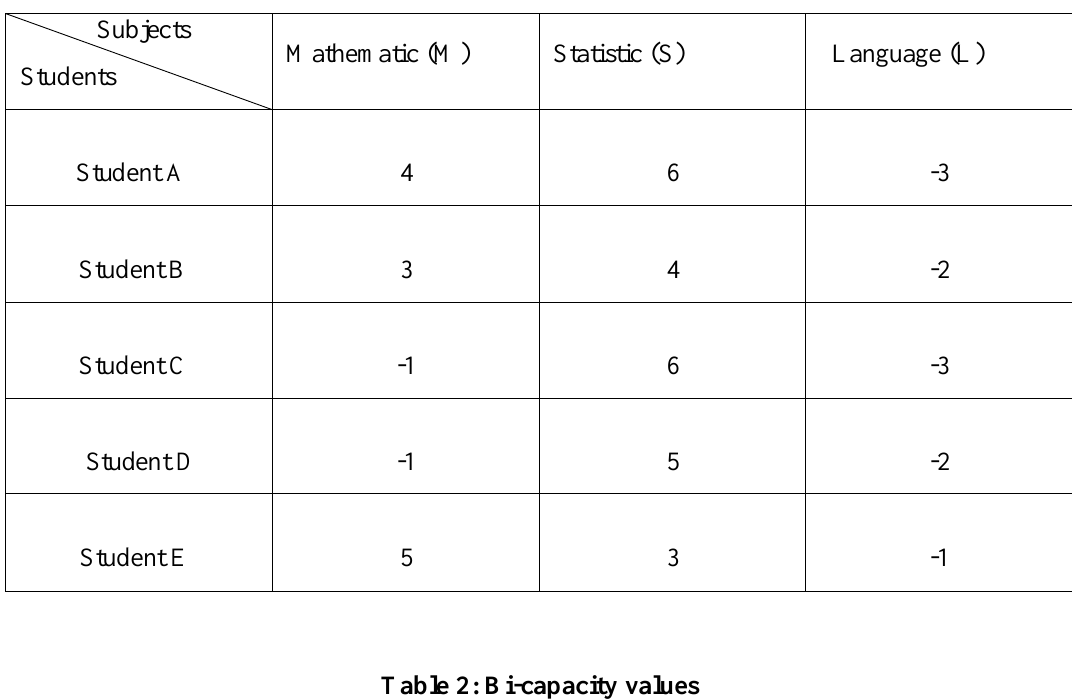
Table 1: Degrees of students